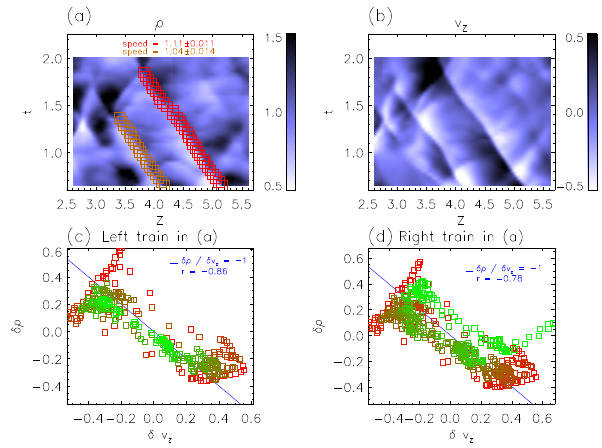
Figure 8. Features of slow wave case 2. In (a) , the orange markers show case 2L and the red ones case